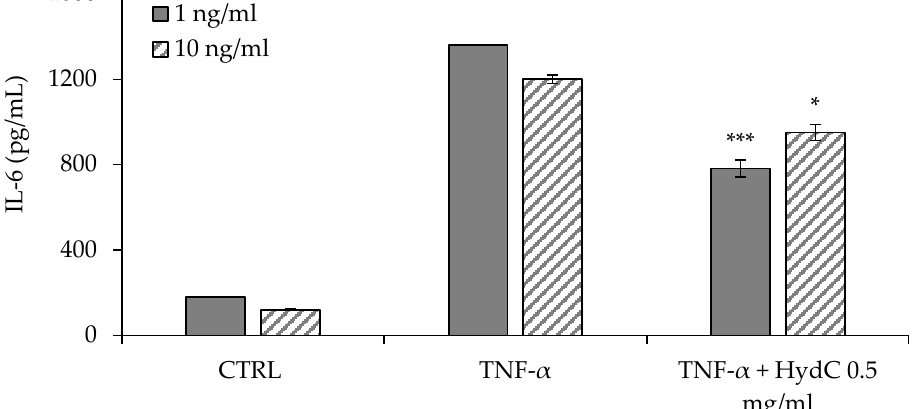
Figure 5. Quantification of IL-6 in HTB-4 cell supernatants after a 24-h stimulation with TNF- α 1 ng/mL (positive control) or TNF- α 1 ng/mL + HydC (HA: 0.5 mg/mL) and with TNF- α 10 ng/mL (positive control) or TNF- α 10 ng/mL + HydC (HA: 0.5 mg/mL) (* p < 0.05; *** p < 0.0001). CTRL: HTB-4 in basal medium.